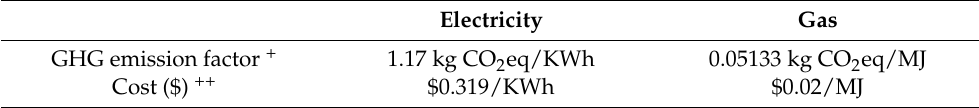
Table 8. GHG emission factor and price for electricity and gas in Victoria.